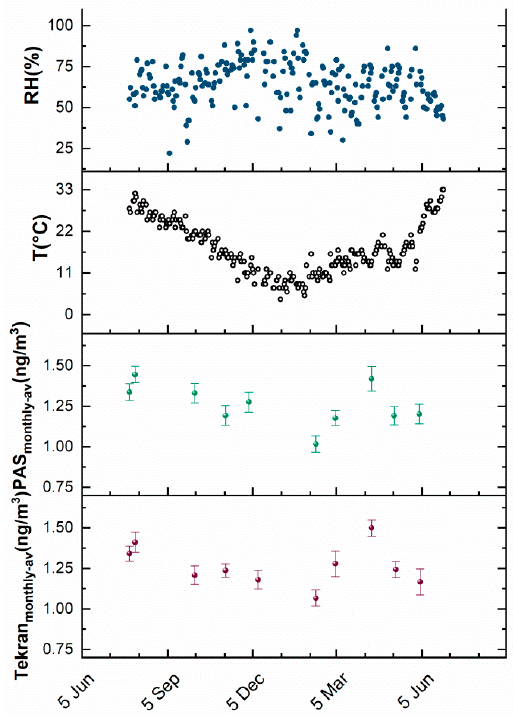
Figure 8. Composite plot depicting the daily trend of %RH ( ● ) and T ( o ) over the sampling time (1 year); averaged data from 1 ‐ month deployed PAS ( ● ) and instrumental data ( ● ) recorded within the same sampling time. The latter were averaged (Tekran monthly ) to be compared to PAS values (PAS monthly ).